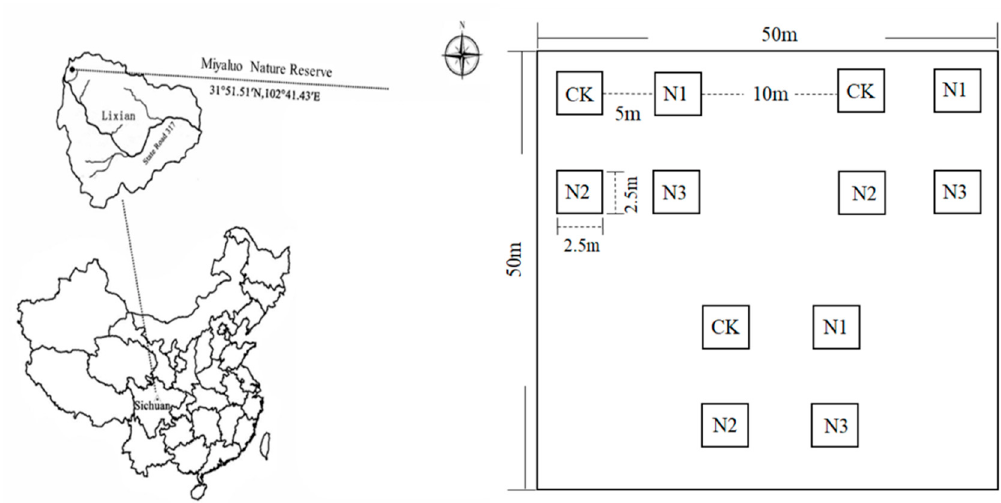
Figure 1. Map of the experimental plots and design. Control check, CK (blank control); N1 (low nitrogen treatment); N2 (medium nitrogen treatment); N3 (high nitrogen treatment).